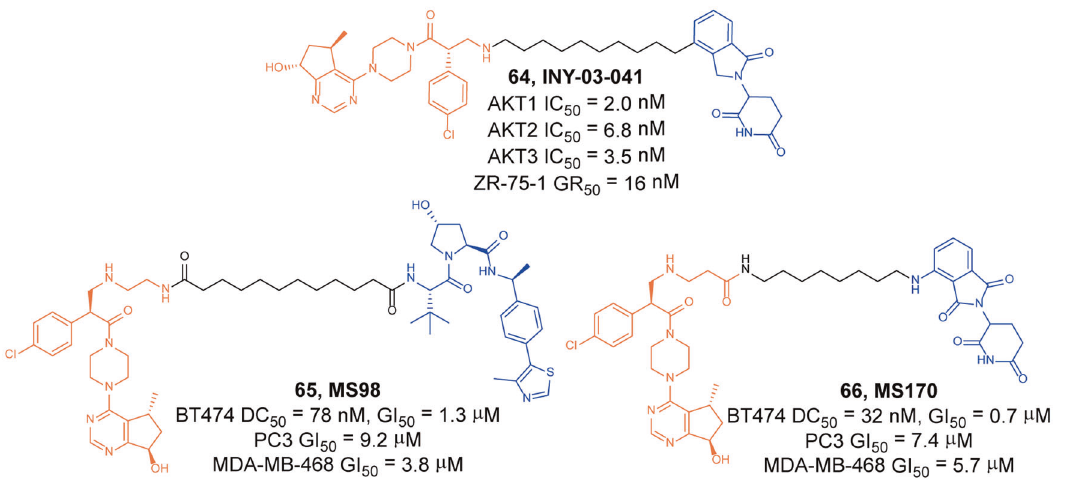
Fig. 18 The representative PROTACs targeting